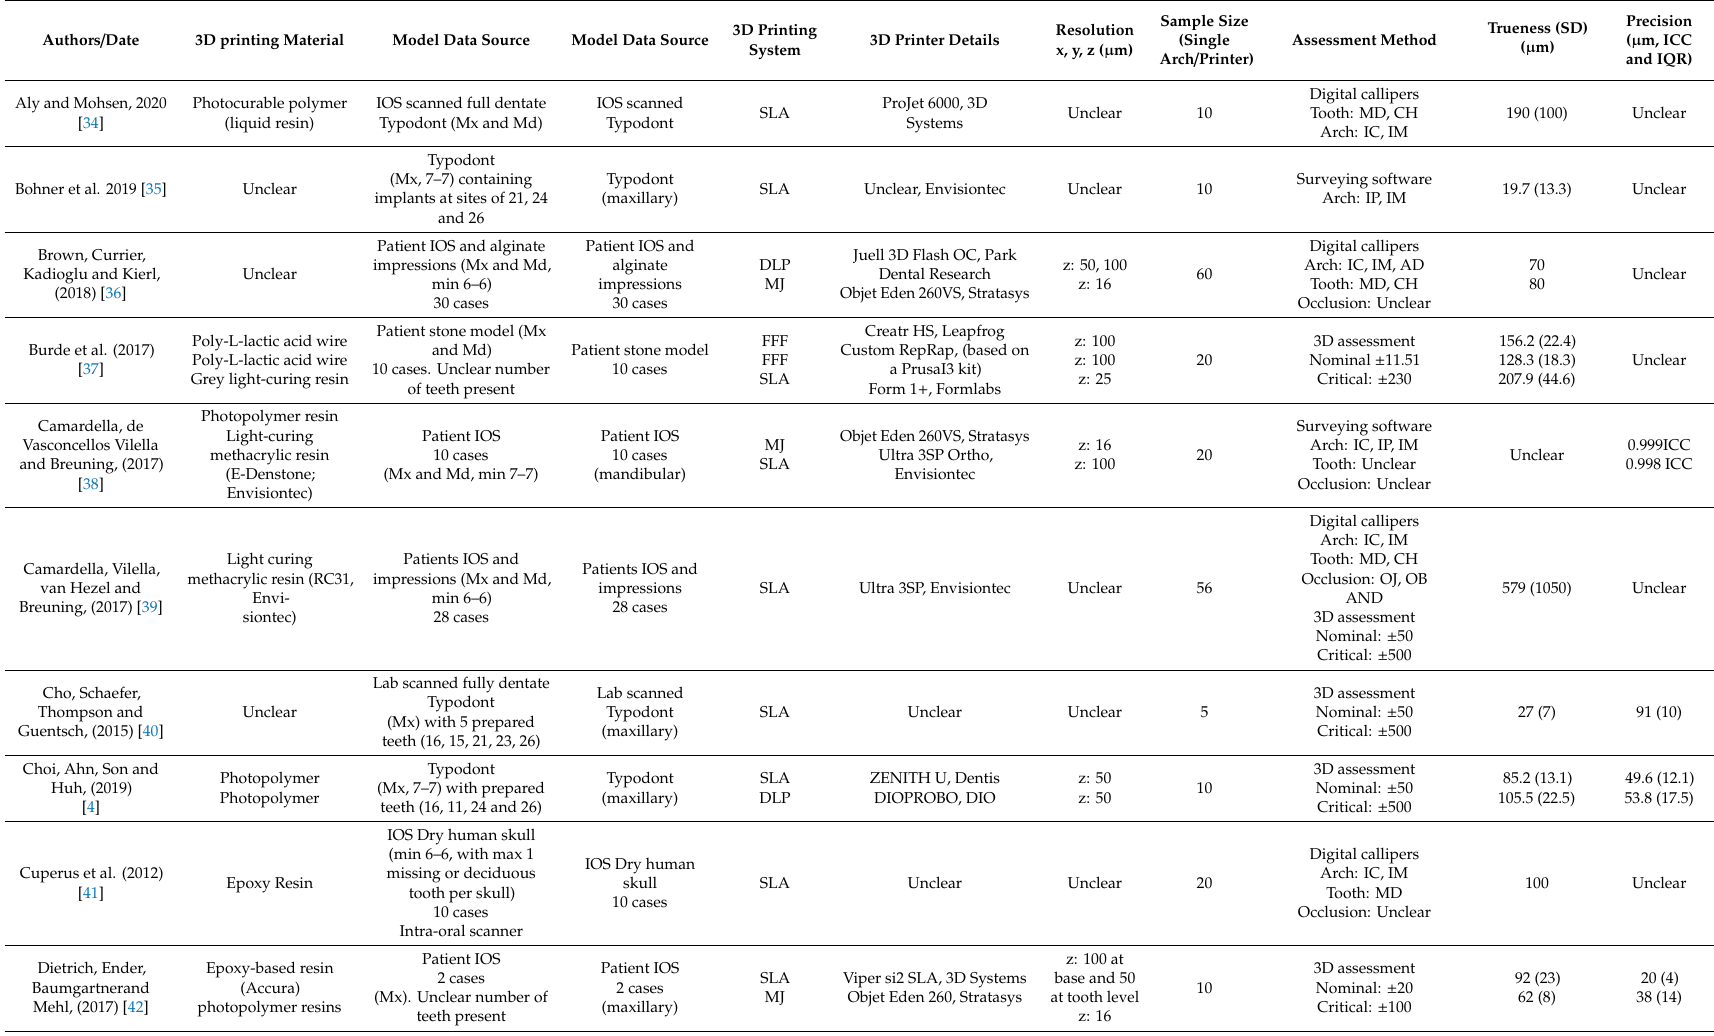
Table 2. Details of studies included in the systematic